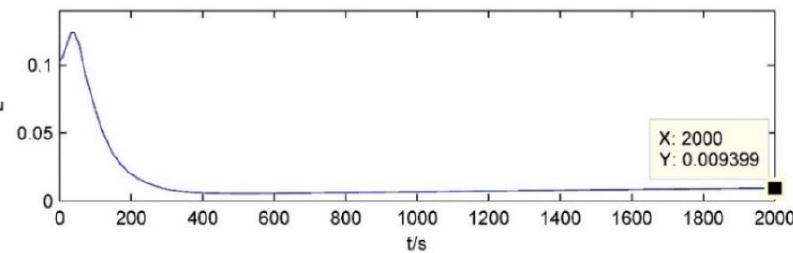
Figure 14. The distribution uniformity of the cluster (in-plane circle formation, µ = − 5